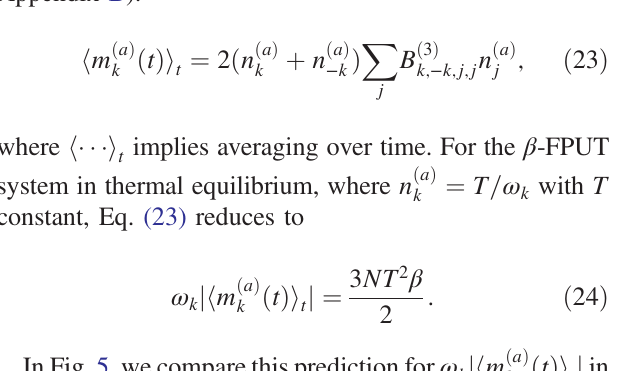
FIG. 4. Fourth-order correlator j Re ½h a k and diagonal lines are visible. Horizontal and vertical lines correspond to trivial resonances: k 1 ¼ k 3 , vertical line; k 2 ¼ k 3 , horizontal line; k 2 ¼ − k 1 þ N , diagonal line. The latter line corresponds to the presence of an anomalous second-order correlator. The intensity of the lines is larger for larger